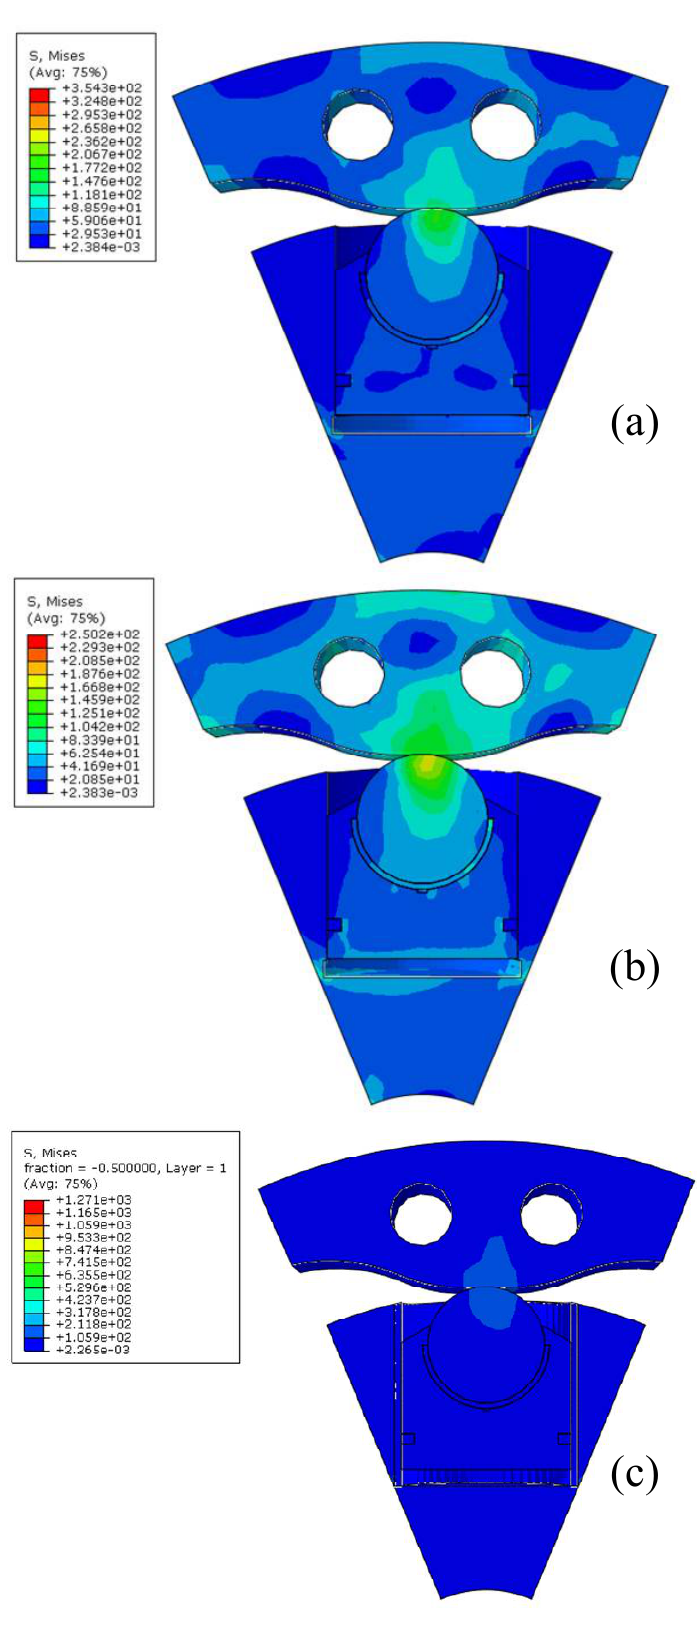
Figure 7. ( a ) Steel, ( b ) aluminum, and ( c ) composite cylinder stress cloud diagram.